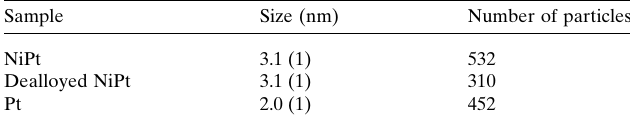
Table 1 Crystallite size of the nanoparticles determined from